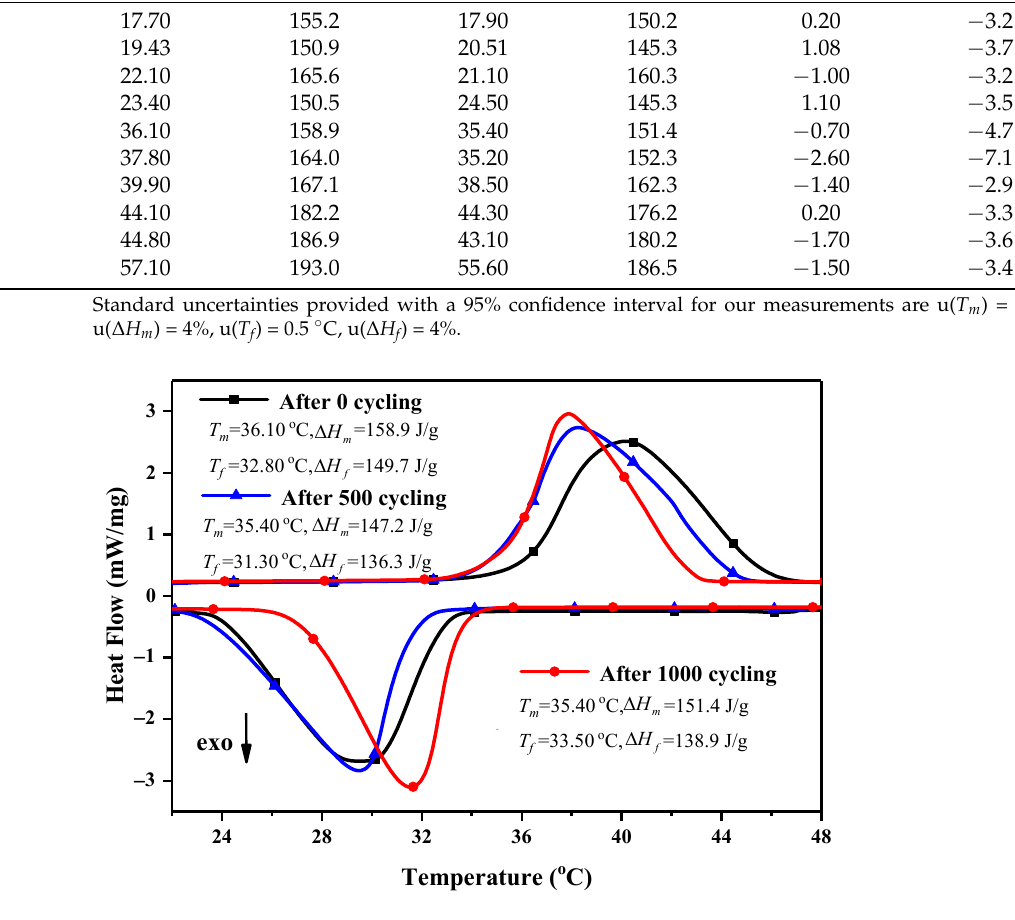
Figure 7. FT–IR spectra of ten fatty acid binary eutectic mixtures before and after 1000 thermal cy ‐ cling ( a ) before thermal cycling, ( b ) after thermal cycling. 4. Conclusions Ten fatty acid binary eutectic mixtures were prepared by using five pure fatty acids as raw materials, and the phase diagrams and the thermal properties of the binary eu ‐ tectic mixtures were systematically studied. (1) The theoretical eutectic points of ten fatty acid binary eutectic mixtures are calculated, and the phase diagrams of ten fatty acids binary eutectic compounds are